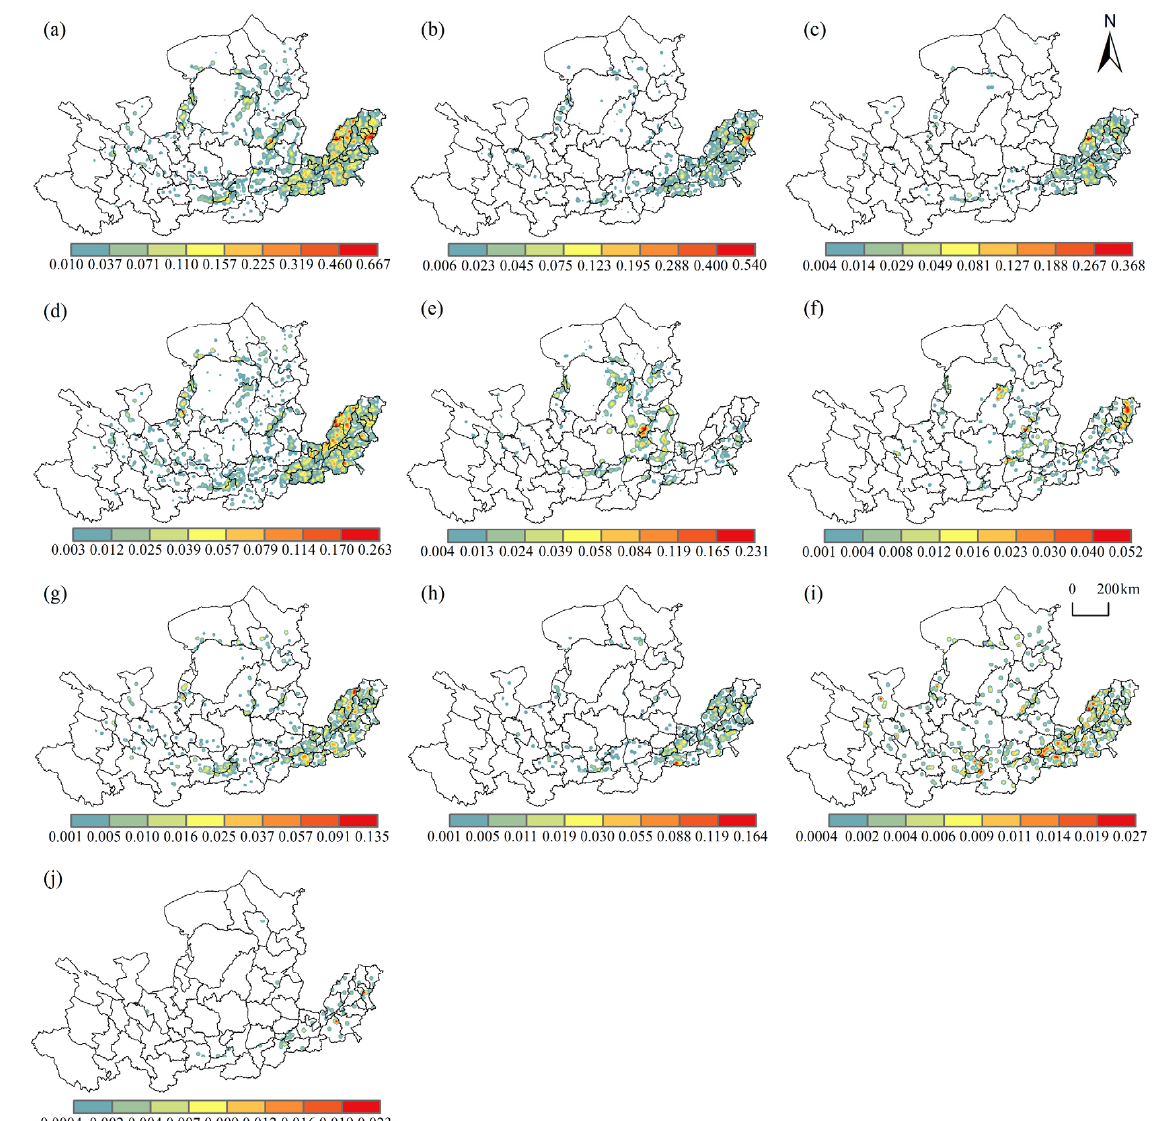
Figure 5. Kernel density of WPIIs in the Yellow River basin. ( a ) A total of 9 kinds of WPIIs; ( b ) manufacture of raw chemical materials and chemical products; ( c ) manufacture of textiles; ( d ) processing of food from agricultural products; ( e ) mining and washing of coal; ( f ) processing of petroleum,